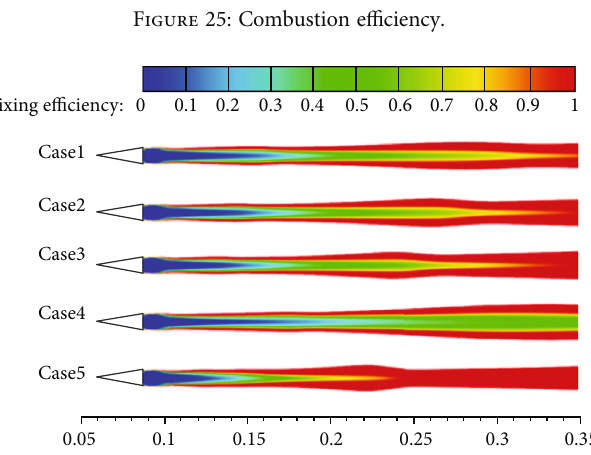
Figure 26: Mixing e ffi ciency for di ff erent cases.